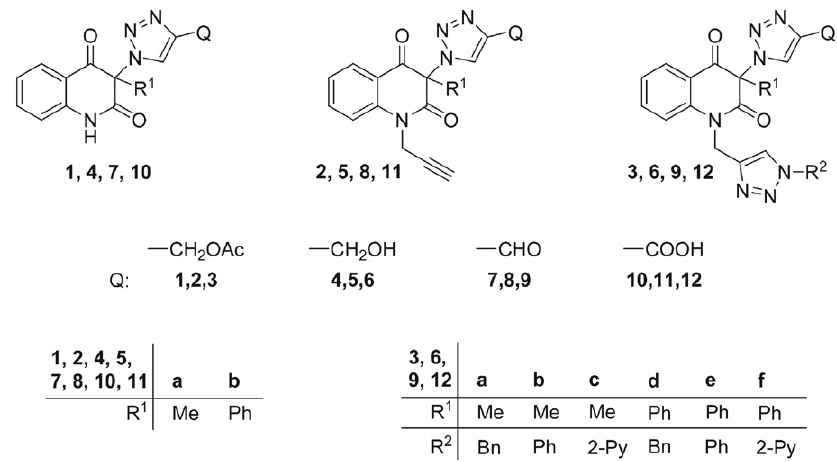
Figure 1. Subject compounds